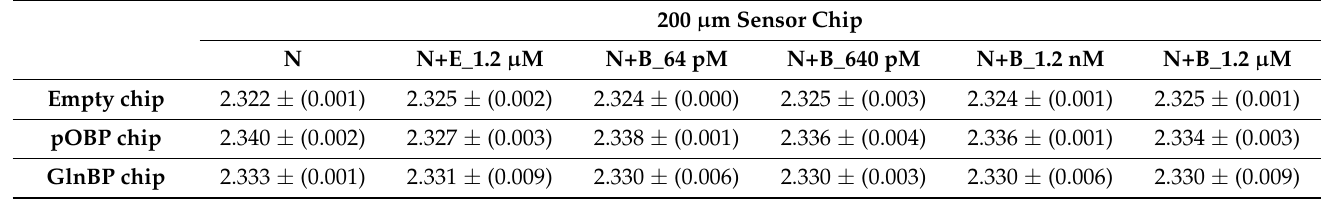
Figure 5. Variation of the voltage value in the absence (nitrogen and ethanol) and in the presence of different concentrations of benzene (from 64 pM to 1.2 µM). The measurements were acquired in gas at room temperature by using the 200 µm sensor chip. Table 2. Variation of the 200 µm sensor chip voltage in three different conditions.